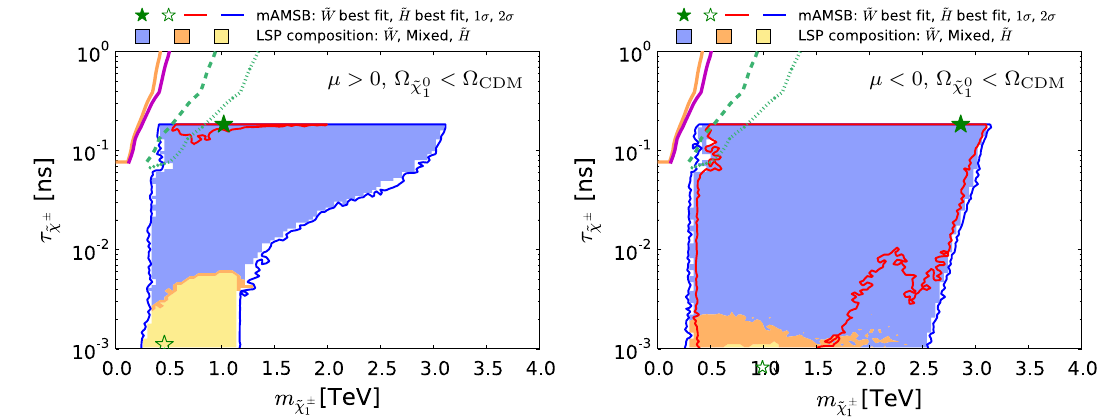
,τ ) plane allowed in the (cid:4) Fig. 20 The region of the ( m ˜ χ ± ˜ χ ± 1 1 μ > 0 ( left ) and μ < 0 ( right ). The orange solid line (cid:4) CDM case for represents the limit from the ATLAS 8-TeV search for disappearing